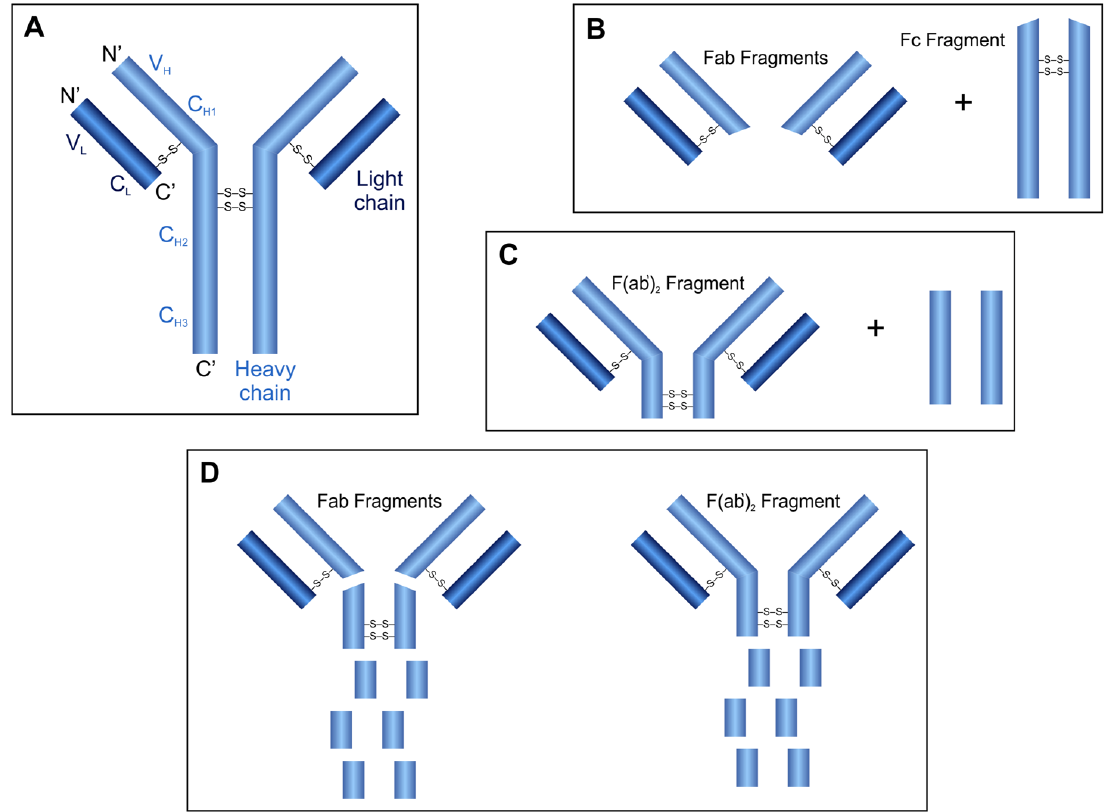
Figure 3. Structure of IgG antibody molecules ( A ) and fragments released after proteolytic digestion using papain ( B ), pepsin ( C ) or ficin ( D